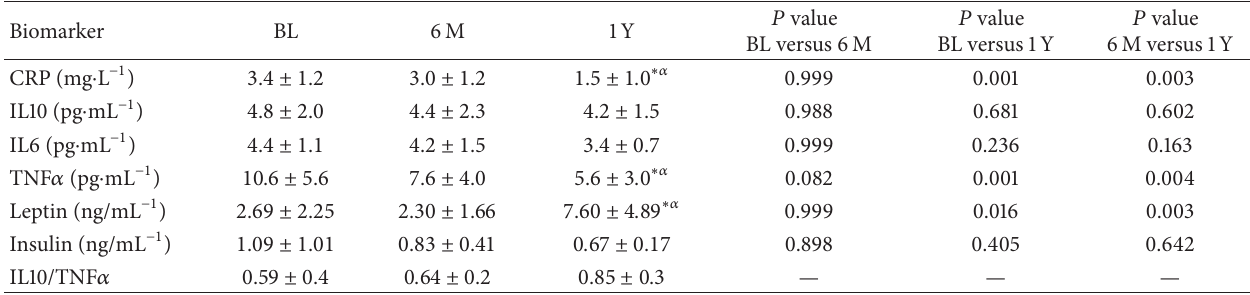
Table 2: Inflammatory biomarkers and hormone concentration levels (mean, standard deviation) at baseline, after 6 months, and after 1 year of exercise